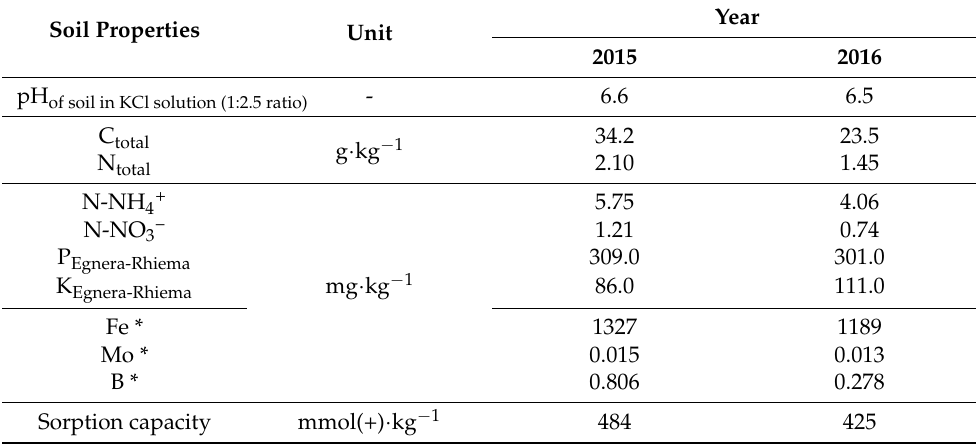
Table 1. Some properties of soil in the layer 0–0.25 m before foundation of experiment in 2015 and